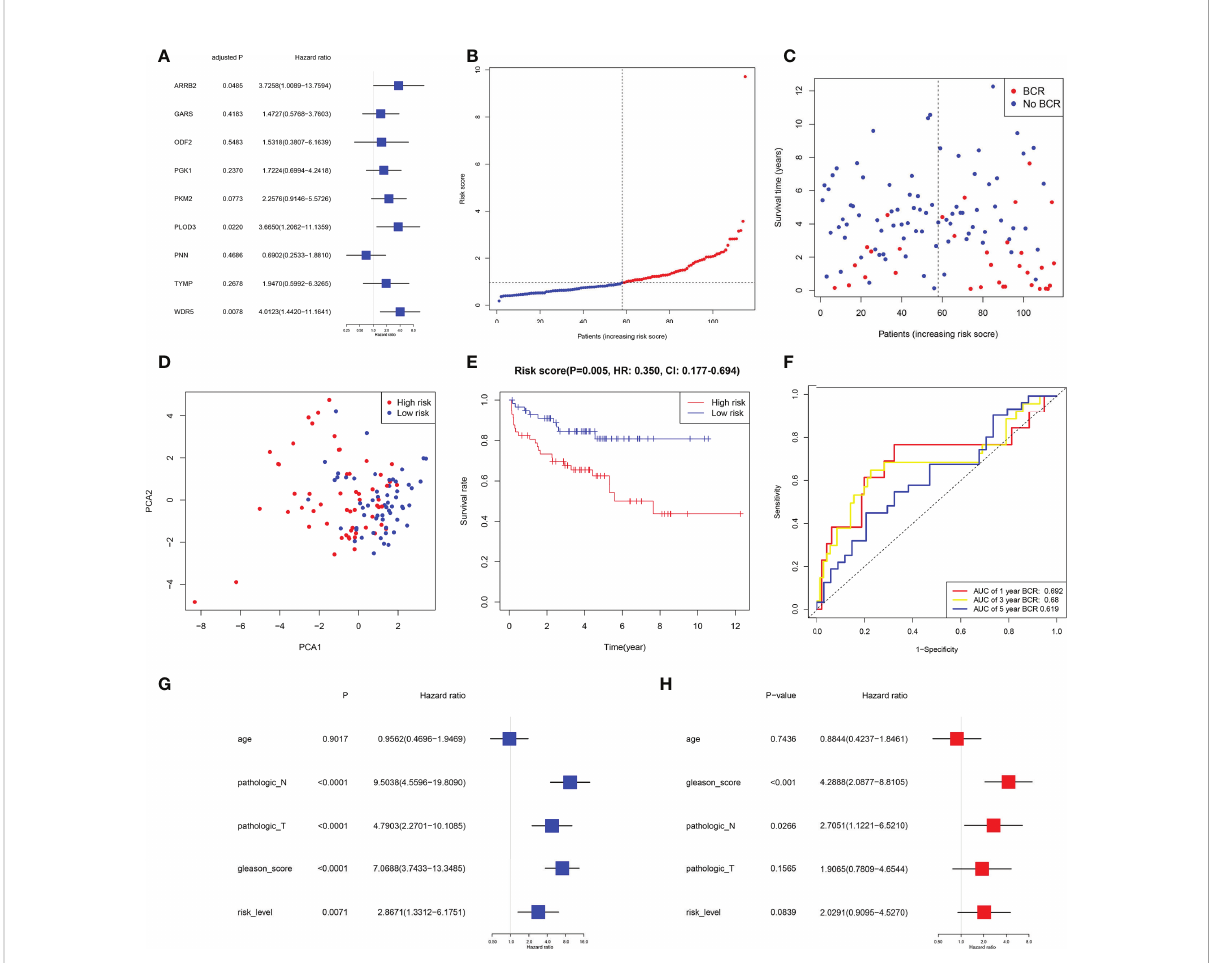
FIGURE 5 External validation of risk signature in GEO cohort. (A) Univariable Cox regression of 9 genes in GEO cohort. (B, C) Distribution, BFFS status and risk score of PRAD patients. D PCA graph for PRAD patients. (E) KM curve for BFFS of PRAD patients based on subgroups. (F) AUC of time- dependent ROC curves. (G, H) Univariate and multivariate Cox regression analysis in GEO